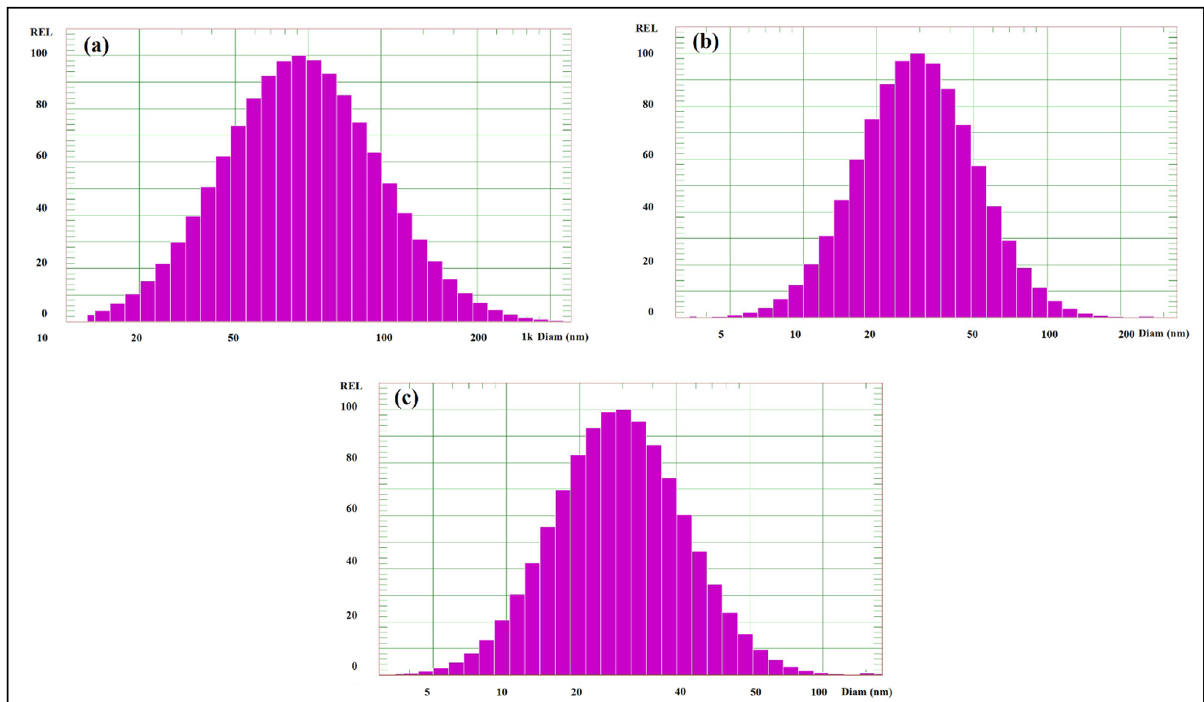
Figure 4: DLS histograms of TiO 2 nanoparticles at di ff erent irradiation doses: ( a ) 10 kGy, ( b ) 20 kGy, and ( c ) 30